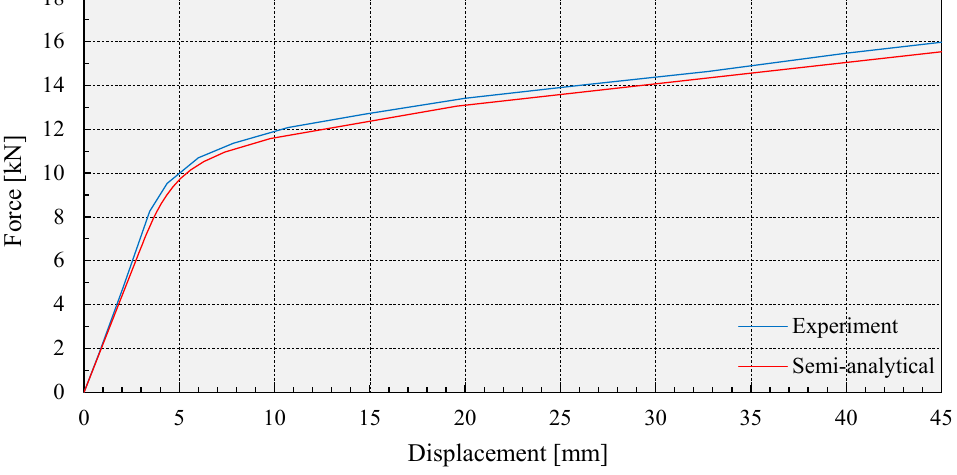
Figure 8. A force–displacement diagram for VC1.